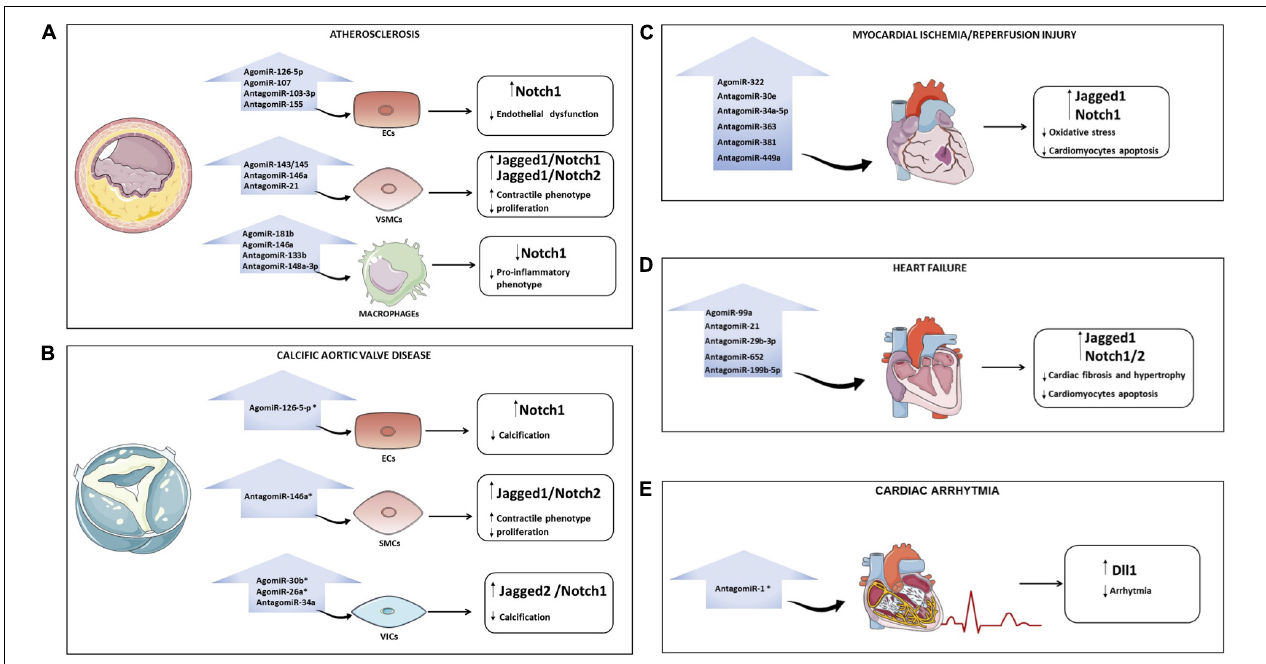
FIGURE 2 | Overview of miRNAs that regulate the Notch pathway in cardiovascular diseases (CVDs). Possible strategies to modulate Notch with miRNAs in CVDs: atherosclerosis (A) , calcification of aortic valve (B) , myocardial ischemia/reperfusion (C) , heart failure (D) , and arrhythmia (E) . For each pathology, the microRNAs that could be overexpressed (through the use of AgomiR) or downregulated (through the use of AntagomiR) to interfere with disease progression are indicated. The asterisk indicates that the role of miRNAs in specific CVD is still poorly investigated. ECs, endothelial cells; VSMCs, vascular smooth muscle cells; VICs, valve interstitial cells; CAVD, calcific aortic valve